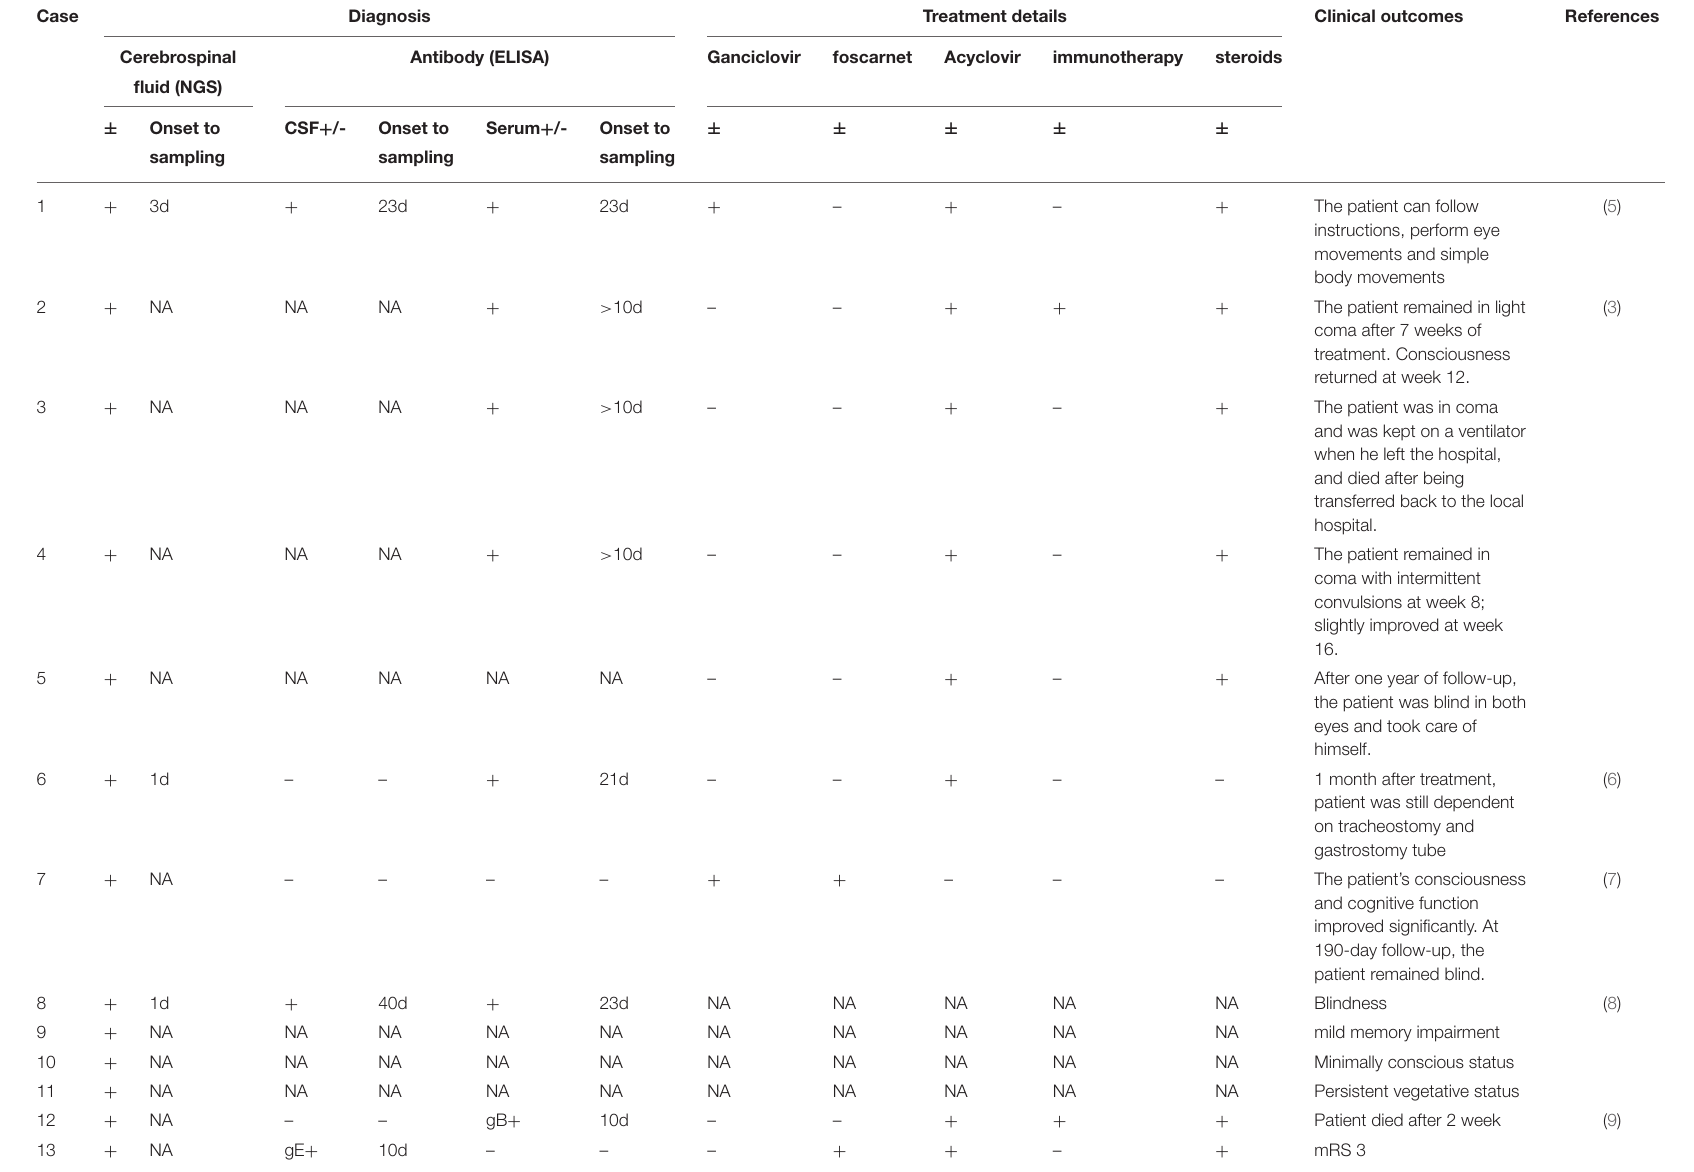
TABLE 2 | Summary of human cases of PRV infection